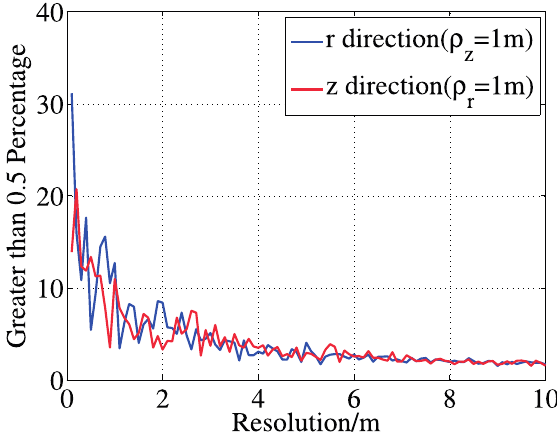
Figure 4. Percentage of high coherent atoms (coefficient ≥ 0.5) in the